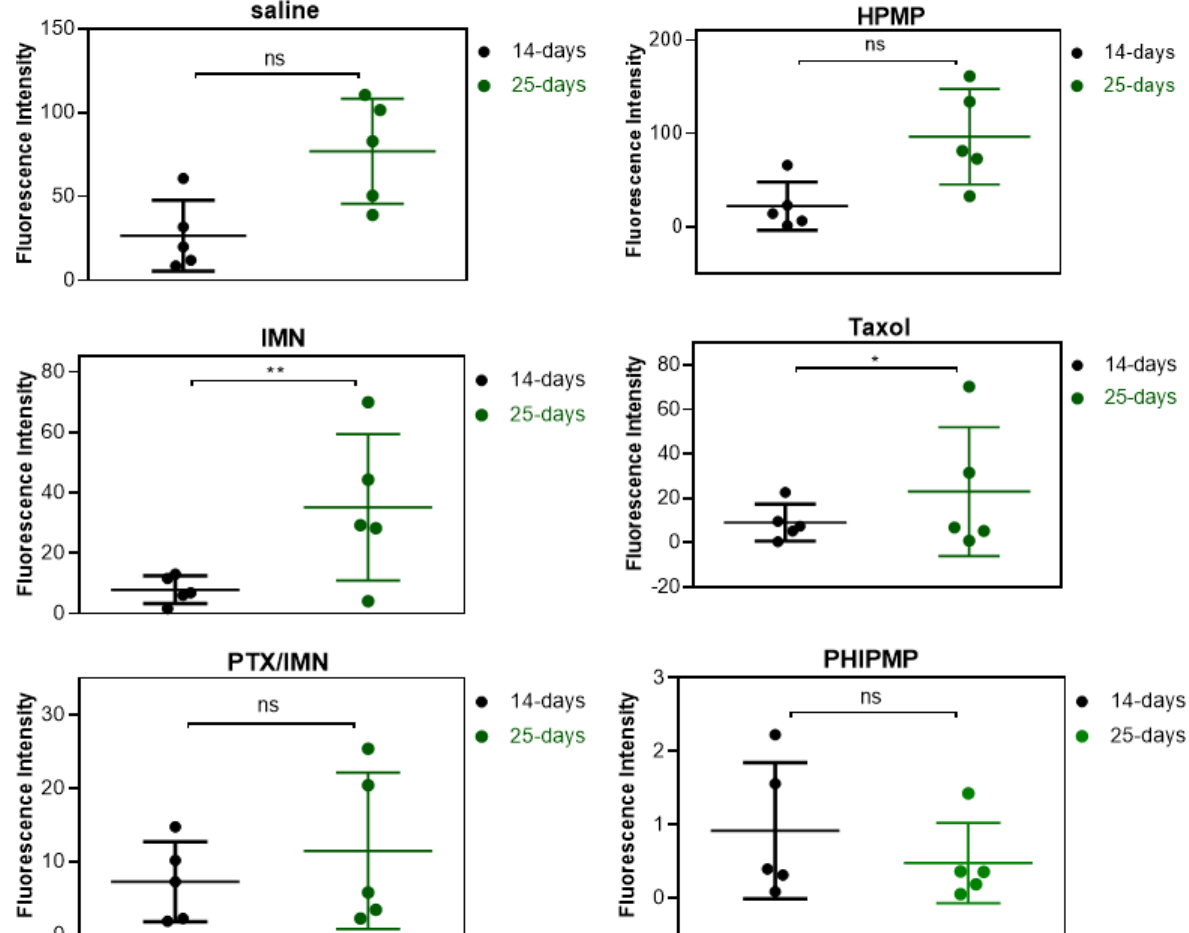
Figure 5. Bioluminescence of each group relative to the tumor-bearing mice on the 14th and 25th days (● the 14th day, ● the 25th day ( n = 5).